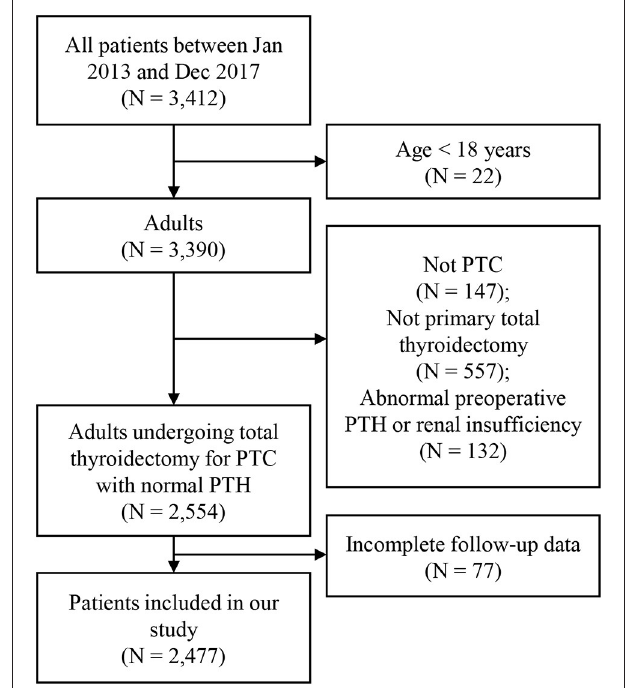
FIGURE 1 | Flow chart of included